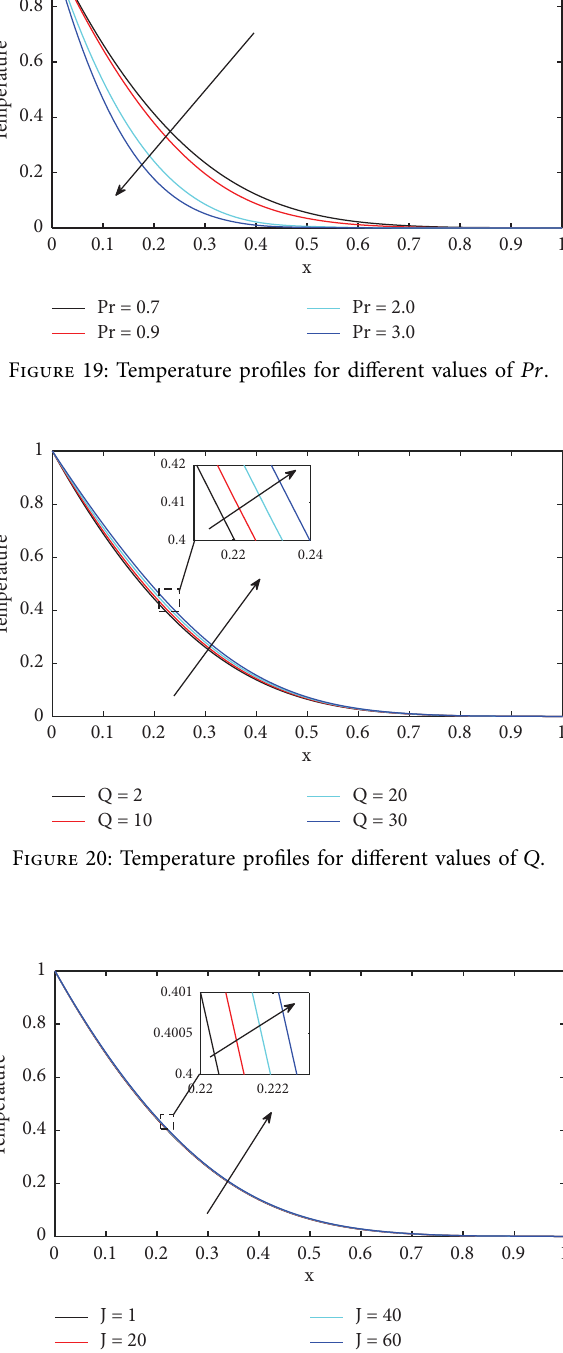
Figure 21: Temperature profles for diferent values of J